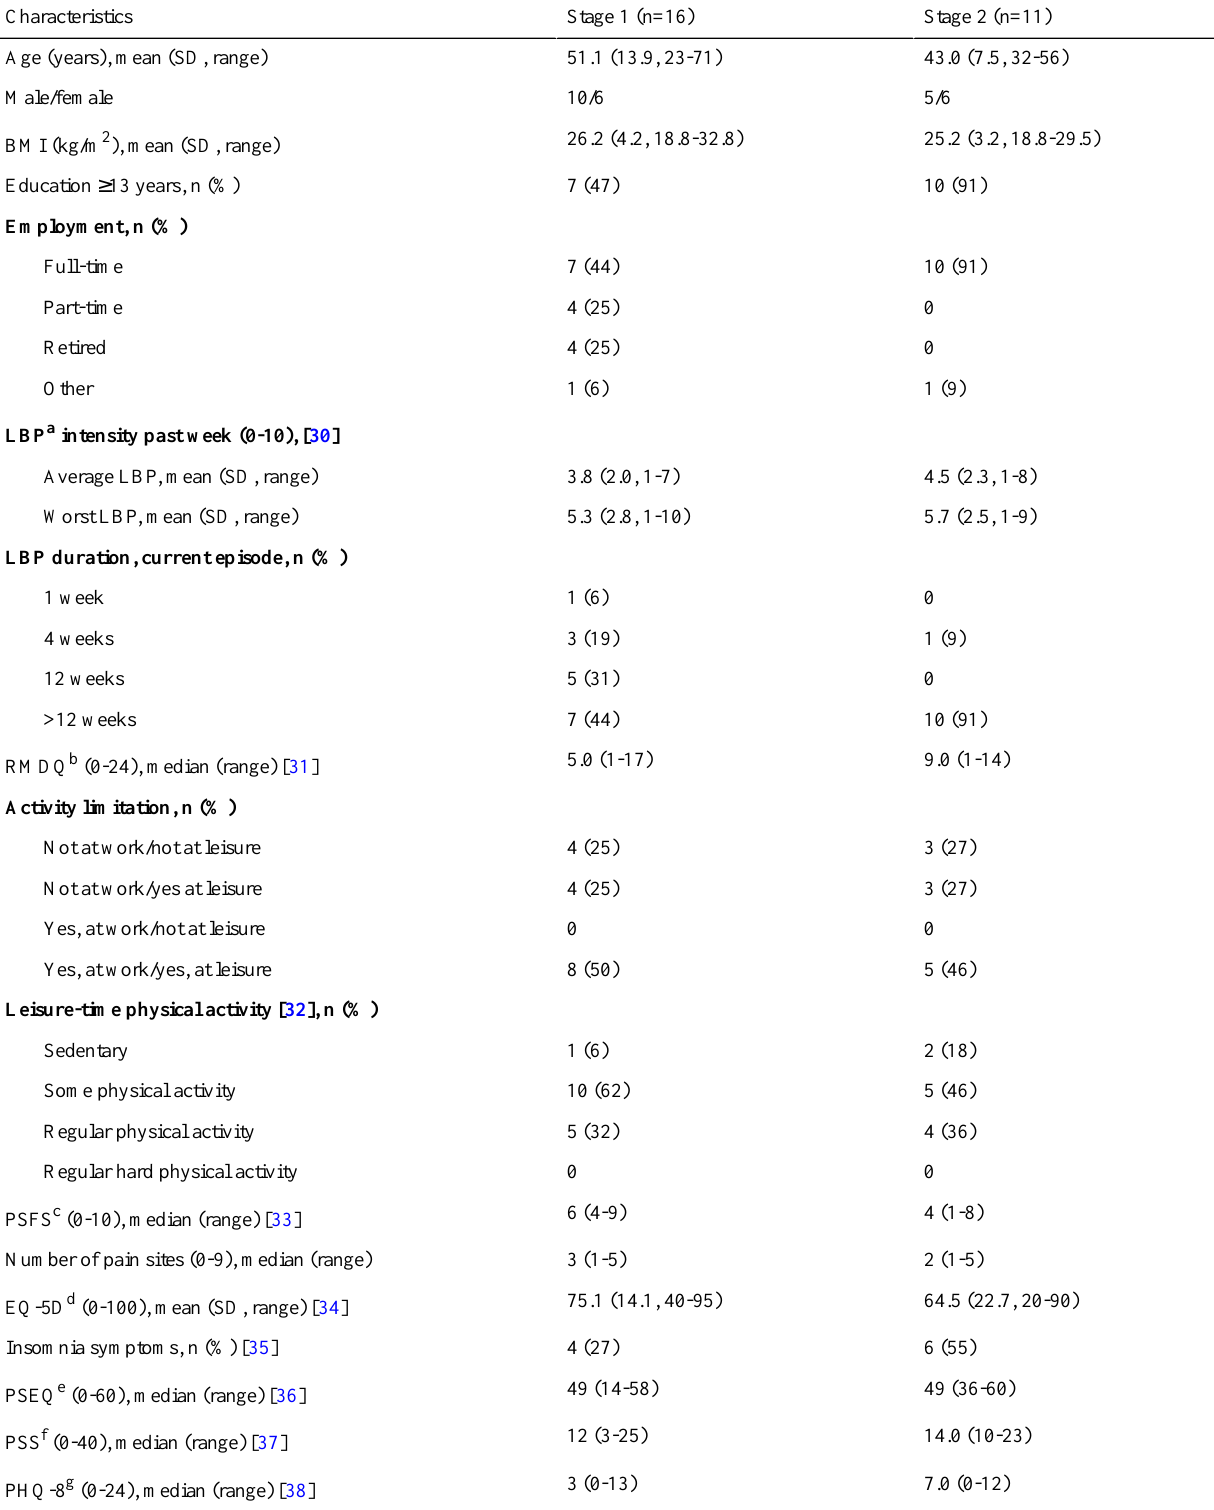
Table 1. Participant characteristics collected with the web